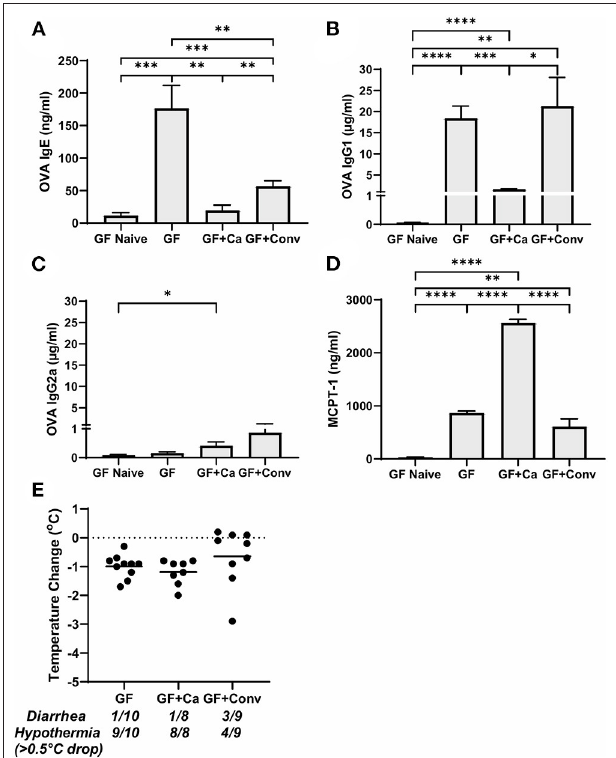
FIGURE 5 | Systemic anaphylaxis markers post-oral antigen exposure in germ-free (GF), CHN1 monocolonized (GF + Ca), and conventionalized (GF + Conv) Balb/cJ mice. Measurements for serum (A) OVA-specific IgE, (B) OVA-specific IgG1, (C) OVA-specific IgG2a, (D) MCPT-1, and (E) body temperature (0-1.5h) were collected for the three groups of mice after challenge seven on day 28 (GF and GF + Ca) or day 42 (GF + Conv). The plot shows average body temperature drop between 15 and 90min, total number of mice with an incidence of diarrhea, and number of mice with hypothermia defined as > 0.5 ◦ C drop per group. Each dot represents a single mouse, and the bars show mean ± SEM; n = 8 to 10 mice. P -values were determined with a Student’s t- test. Statistical significance is * P < 0.05, ** P < 0.01, *** P < 0.001, and **** P <